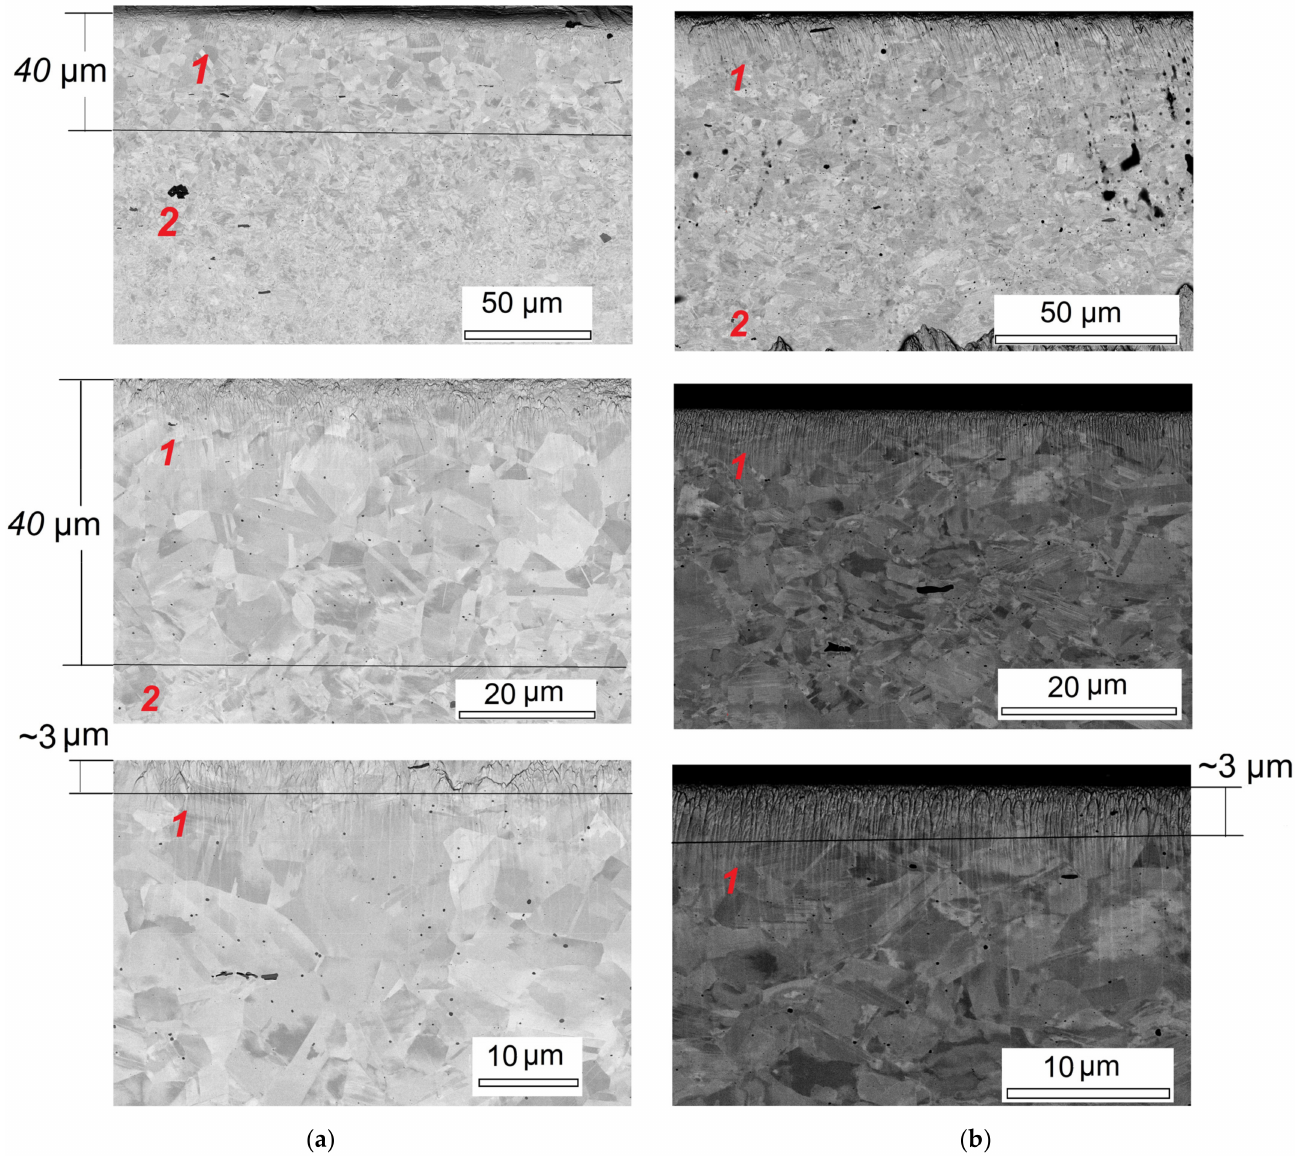
Figure 10. SEM image of a cut surface of a stainless steel sample in the initial ( a ) and after irradiation ( b ) states at various magnifications (1—the zone with relatively equiaxed grains, 2—the zone of deformed